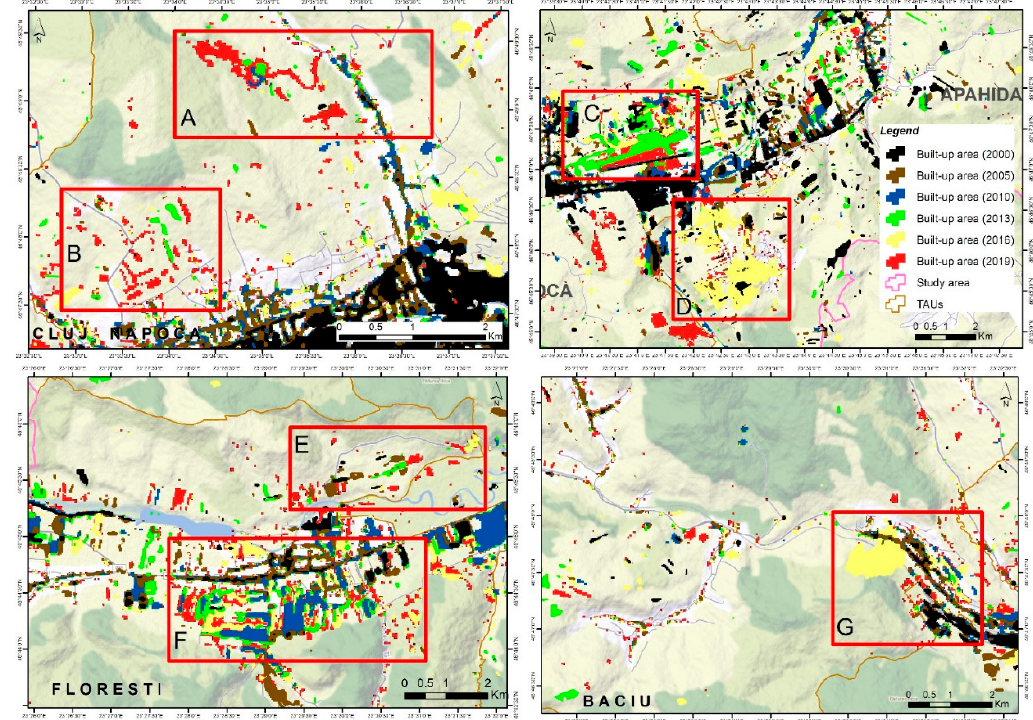
Figure 7. Built-up area dynamics in the period between 2000 and 2019.